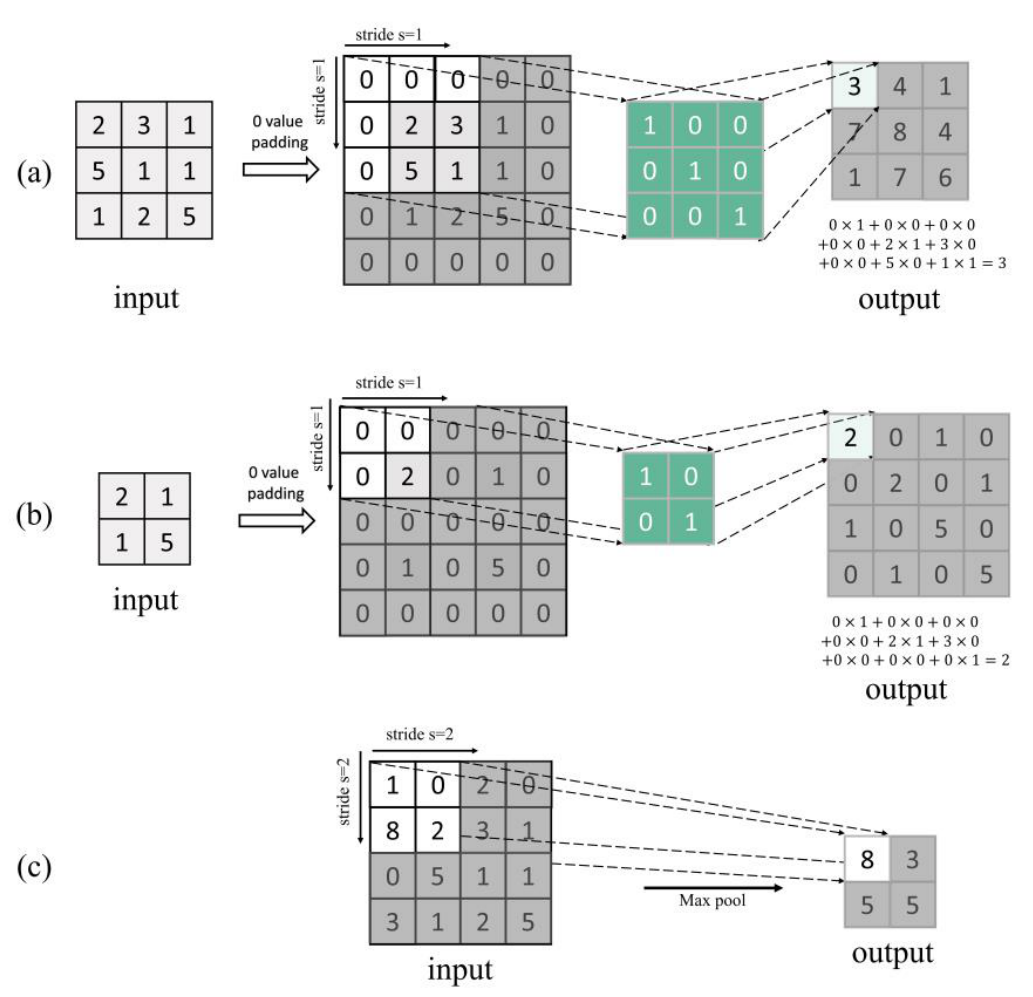
Figure 8. Three common operations of CNN: ( a ) convolution operation; ( b ) transpose convolution operation; ( c ) max pooling operation.